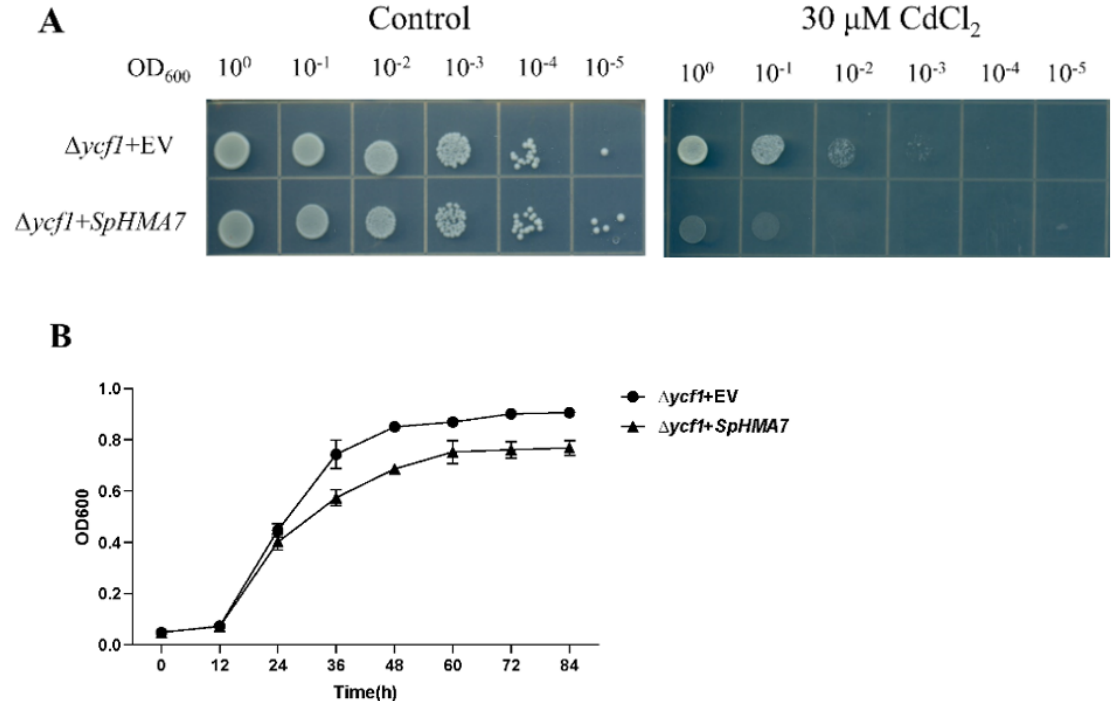
Figure 8. Effects of the overexpression of SpHMA7 in yeast. ( A ) the growth of ∆ ycf 1 yeast mutants transformed with the empty vector pYES2.0 and SpHMA7 ; ( B ) growth curves of SpHMA7 and the control heterologously expressed in the strains of yeast in SG-U liquid medium treated with 30 µ M CdCl 2 .